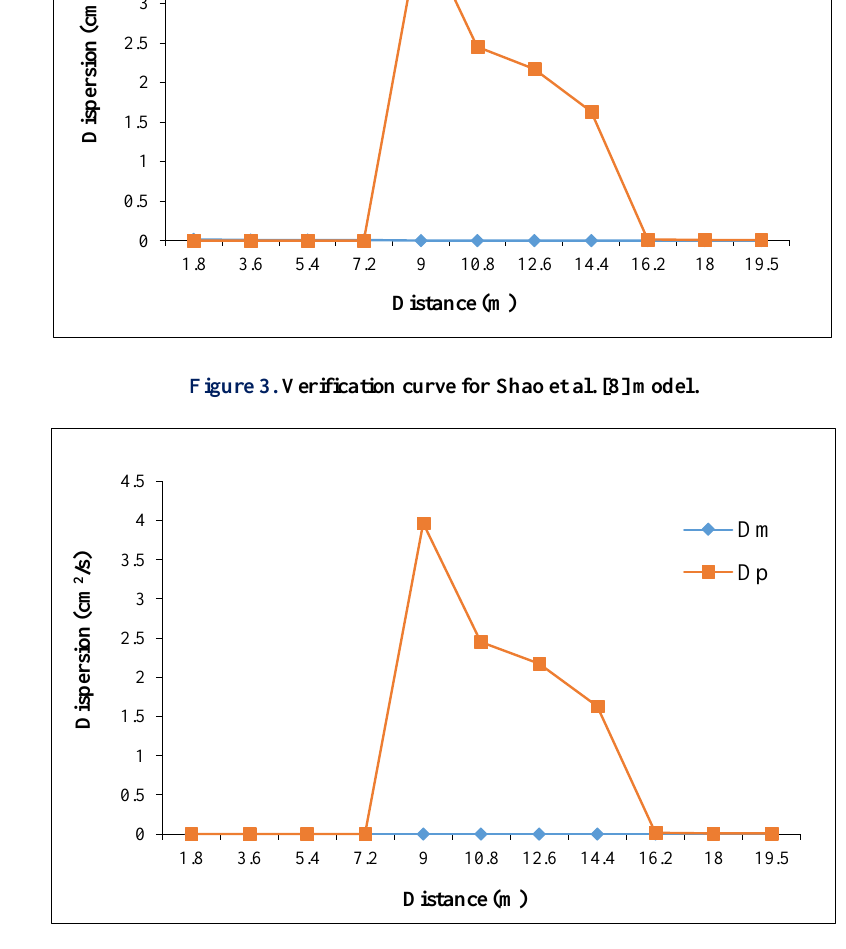
Figure 4. Verification curve for De Smeldt and Wierenga [9]